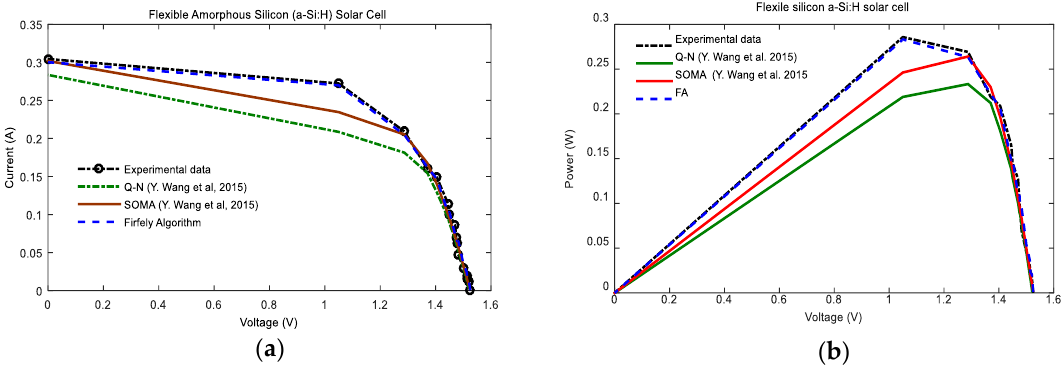
Figure 11. Comparison between, ( a ) I - V and ( b ) P - V characteristics resulting from the experimental data, Q-N, Soma and FA.